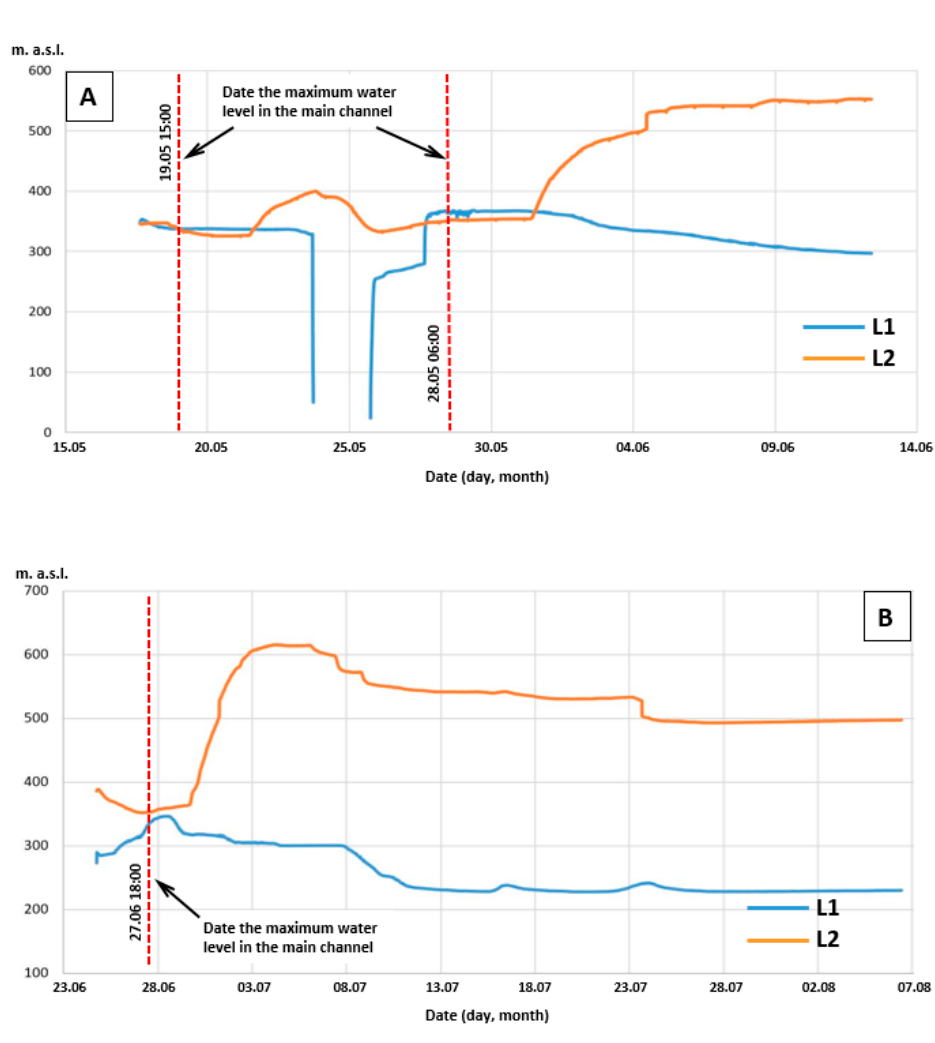
Figure 9. Electrolytic conductivity in piezometer located in the crevasse channel and in an untrans- formed terrace in 2019 ( A ) and 2020 ( B ). The red line marks the maximum water level between the embankments (peak of the surge).